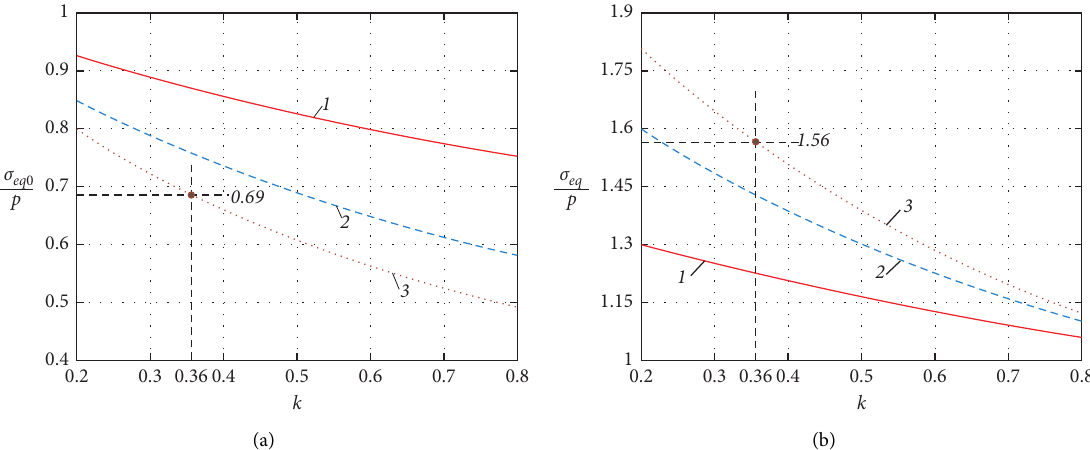
Figure 5: Equivalent stresses in the two-layer column: (a) stress in the layer of PETF concrete; (b) stress in the concrete